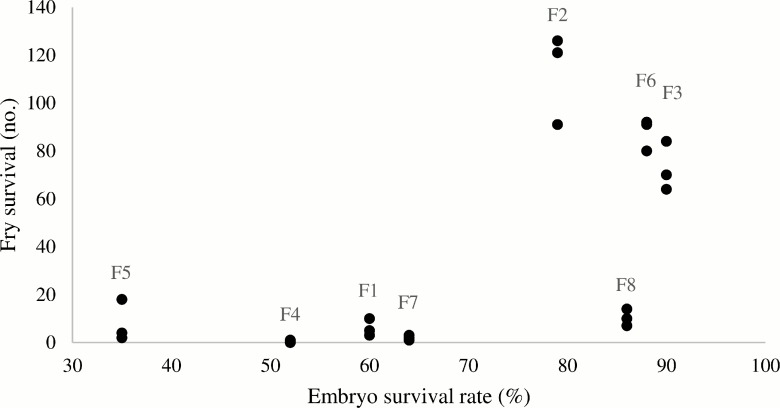
Scatterplot of survival in the fry stage versus survival in the embryo stage.For each observation of embryo survival, there are three replicate observations of fry survival. Labels above indicate batch identity.